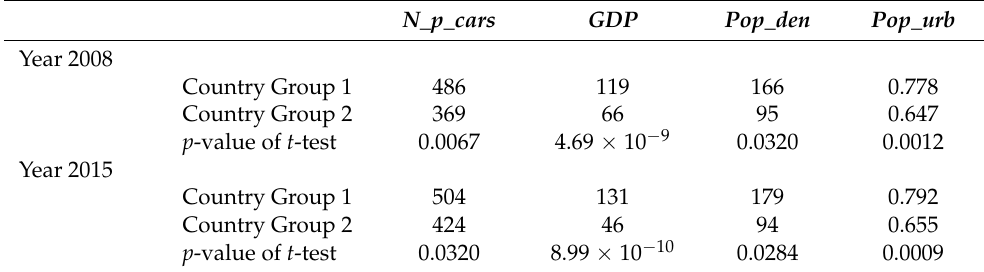
Table 3. The average values of four background indicators related to different country groups and different years, as well as the p -value from the hypothesis